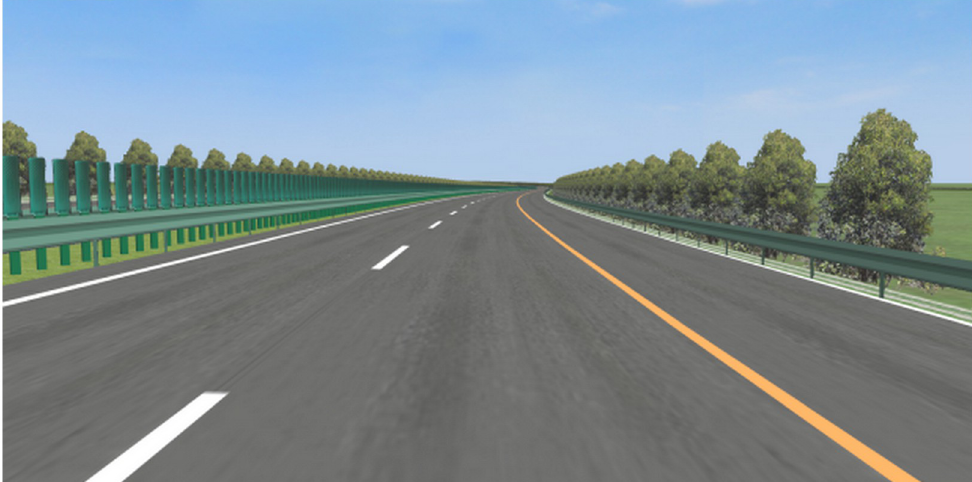
Fig 5. Schematic diagram of simulated road (S-shape